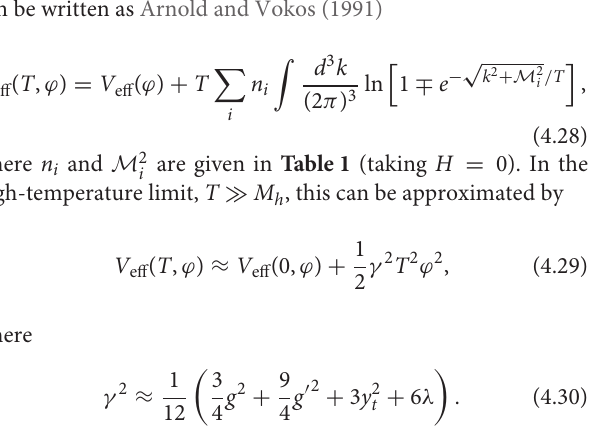
where the numerical value corresponds to the action